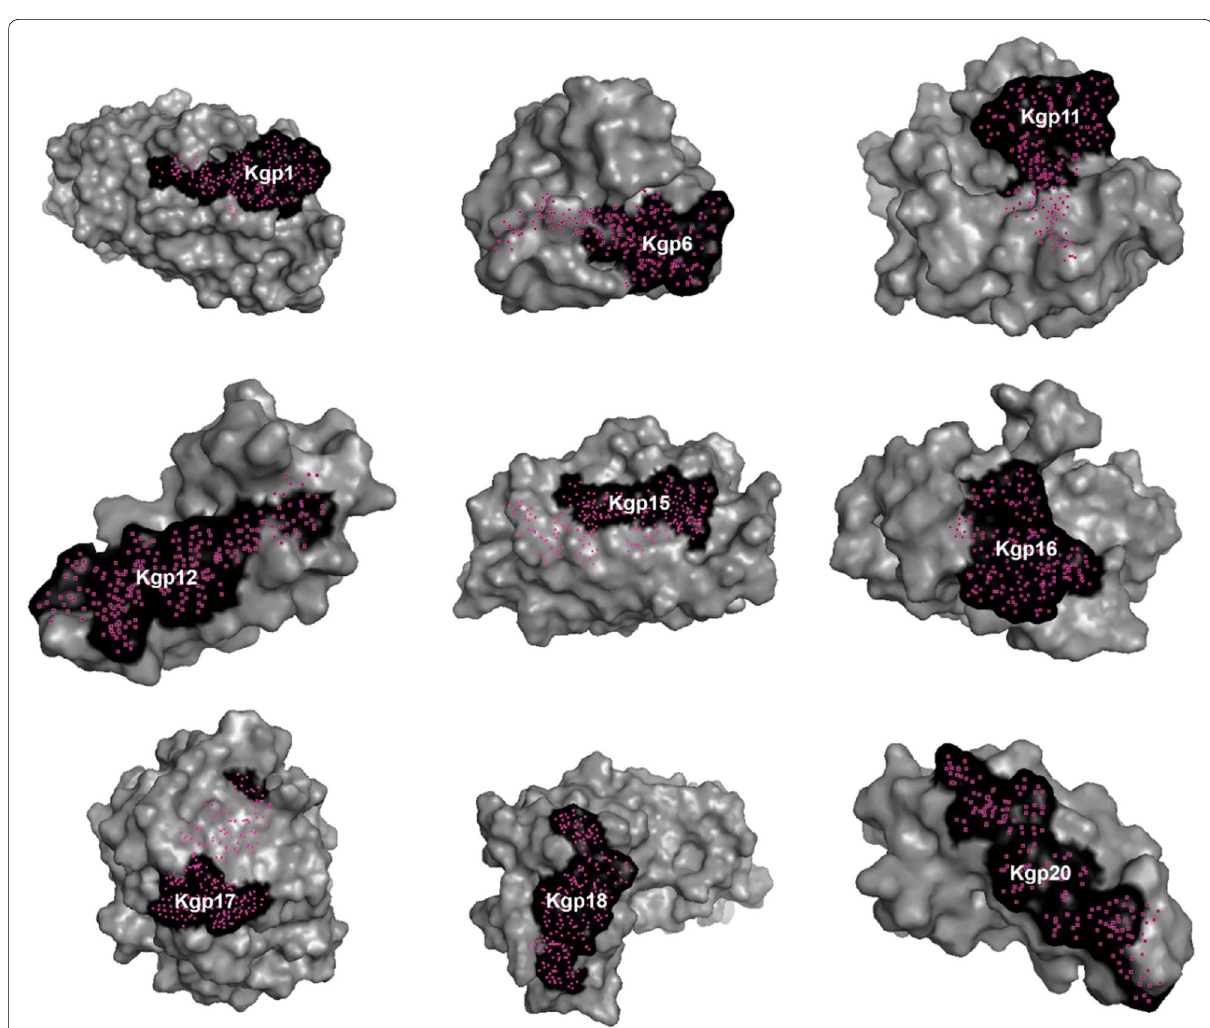
Fig. 2 Kgp peptides. Kgp 1, 6, 11, 12, 15, 16, 17, 18 and 20 are schematically presented in black in their protein region after its modeling. Brazil,